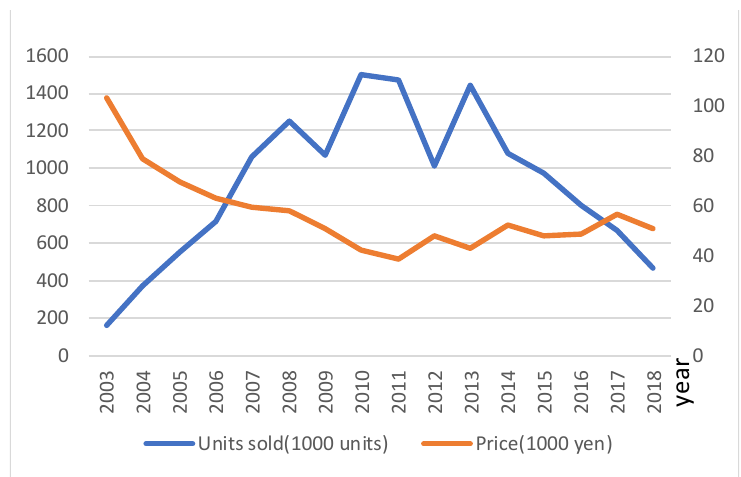
Figure 3. Units sold and price of DSLR